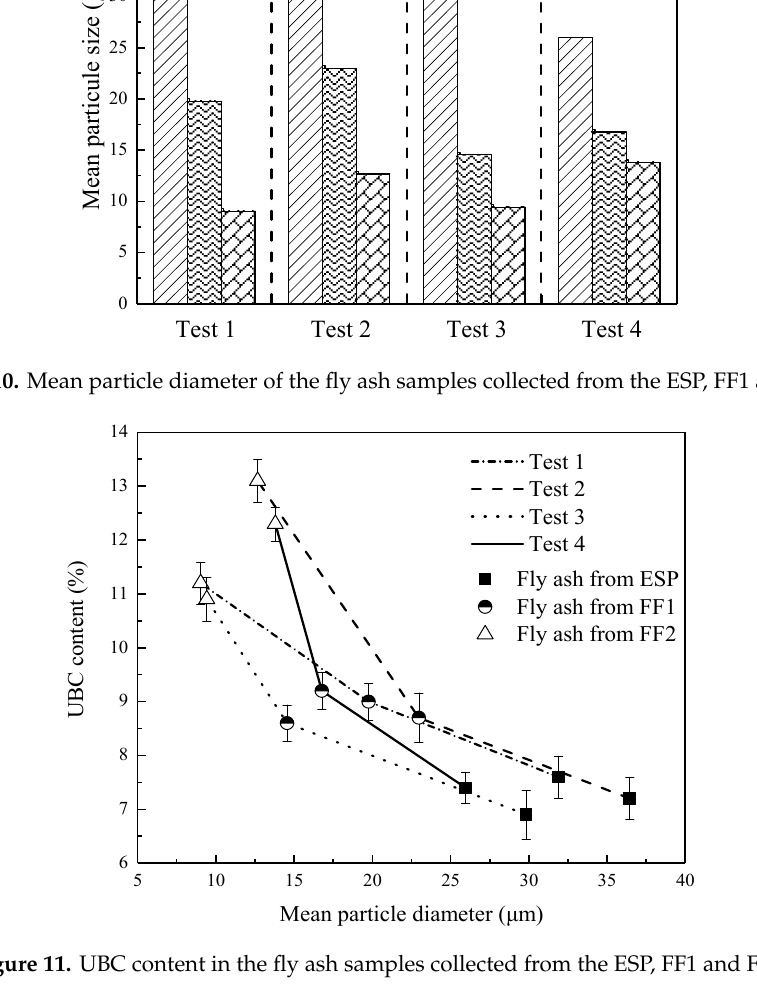
Figure 11. UBC content in the fly ash samples collected from the ESP, FF1 and